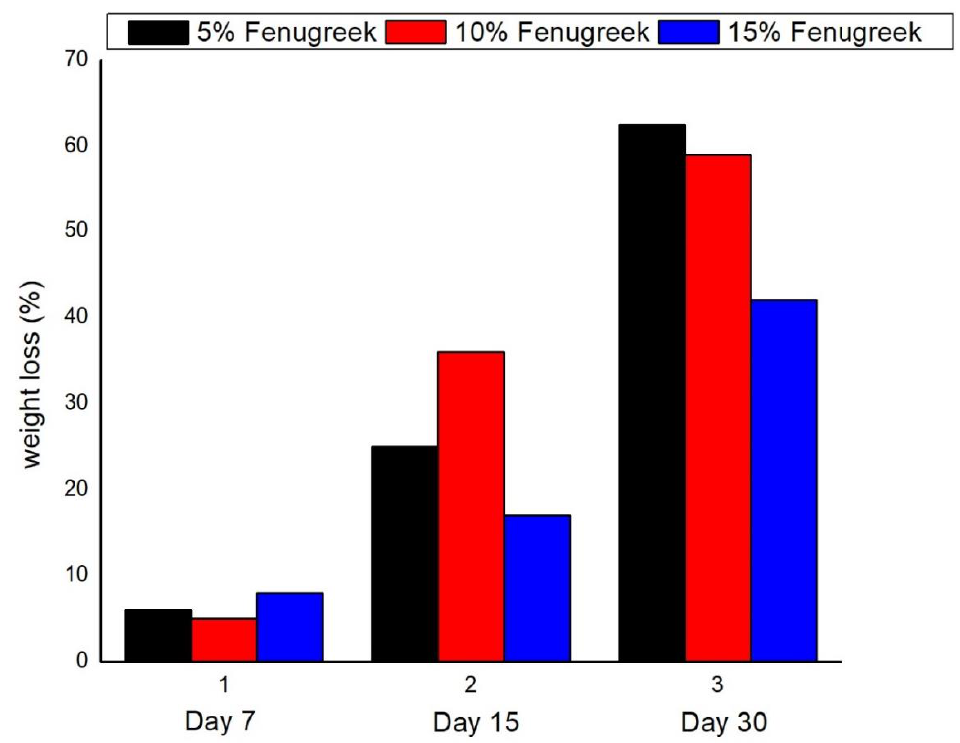
Figure 6. Biodegradibility comparison of the synthesized bio-composites at different percentages of fenugreek.